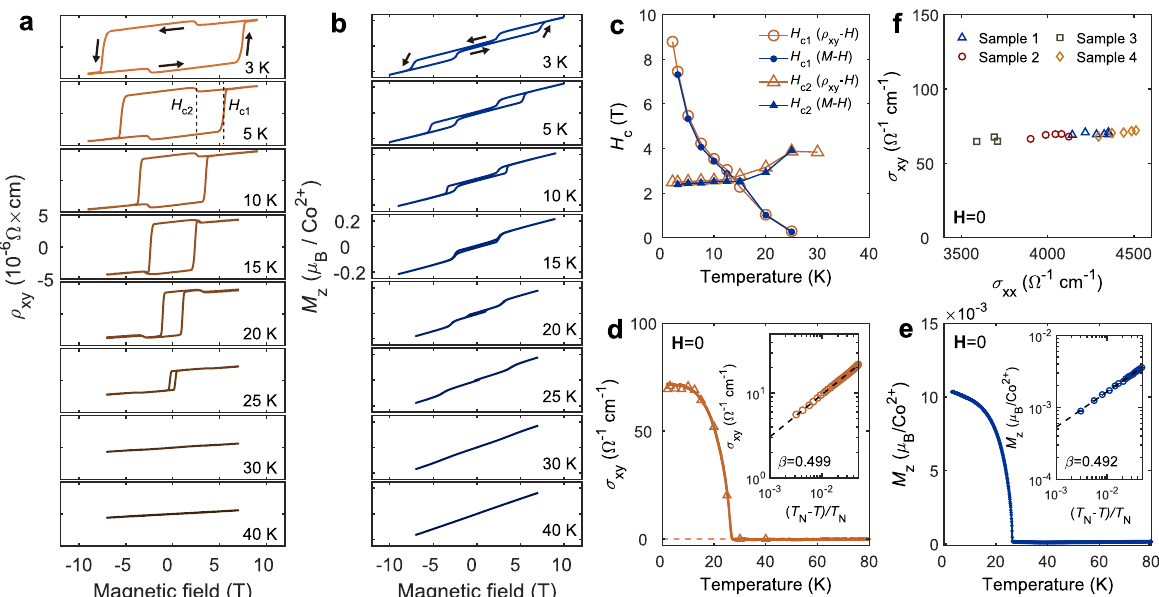
Fig. 2 Anomalous Hall effect and its comparison to weak ferromagnetism. a , b The fi eld dependence of Hall resistivity ρ magnetization along the c -axis at several temperatures. c Temperature dependence of H c1 (circles) and H c2 (triangles) determined from the ð H Þ (hollow symbols) and M ð H Þ ( fi lled symbols) curves. d , e Temperature-dependent zero- fi eld Hall conductivity ( σ ρ z xy magnetization along the c -axis ð M z ð H ¼ 0 ÞÞ , measured after a fi eld cooling process (see “ Methods ” ). Inset shows the critical behavior of ð T ; H ¼ 0 Þ and M ð T ; H ¼ 0 Þ near 26.5 K and fi tted results (black dashed lines) with β = 0.499 and 0.492, respectively. f A plot of the σ xy z longitudinal and zero- fi eld anomalous Hall conductivity for several Co x TaS 2 samples (0.31 < x < 0.325, see Supplementary Fig. 6), which were extracted from the ρ xy H ð Þ curves measured below 15